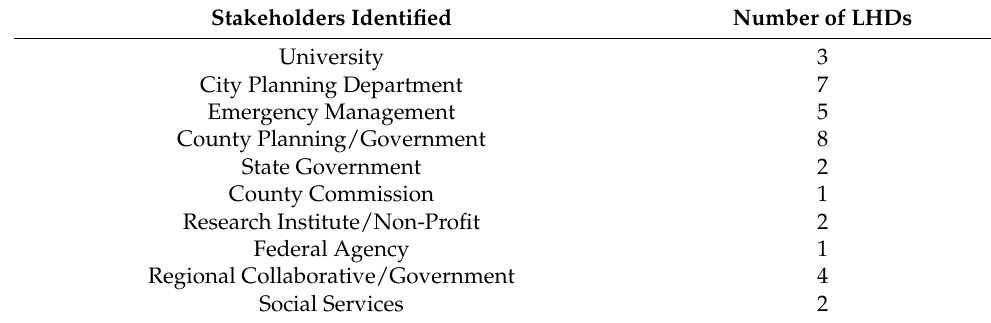
Table 3. Relevant/Potential Stakeholders Identified by Local Health Departments (LHDs) in